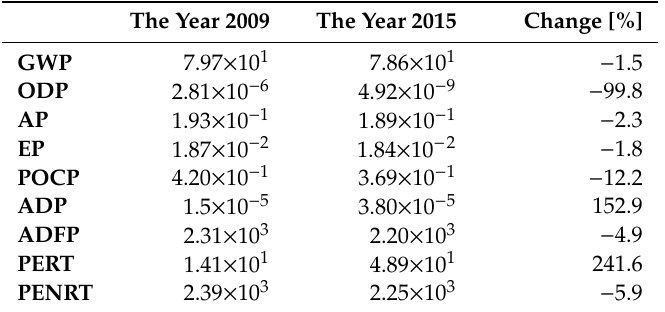
Table 6. Comparison of LCA results for expanded polystyrene. The data were provided by the Association for European Manufacturers of Expanded Polystyrene members across Europe. Comparison based on data obtained from production between 2009 and 2015